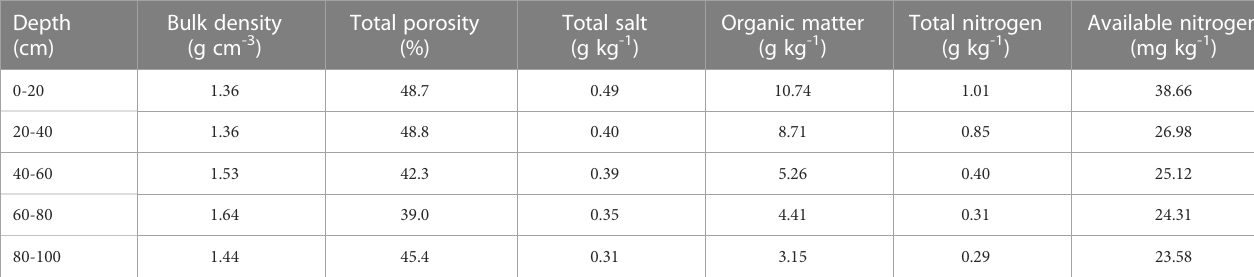
TABLE 1 The basic soil properties in the study area. Depth